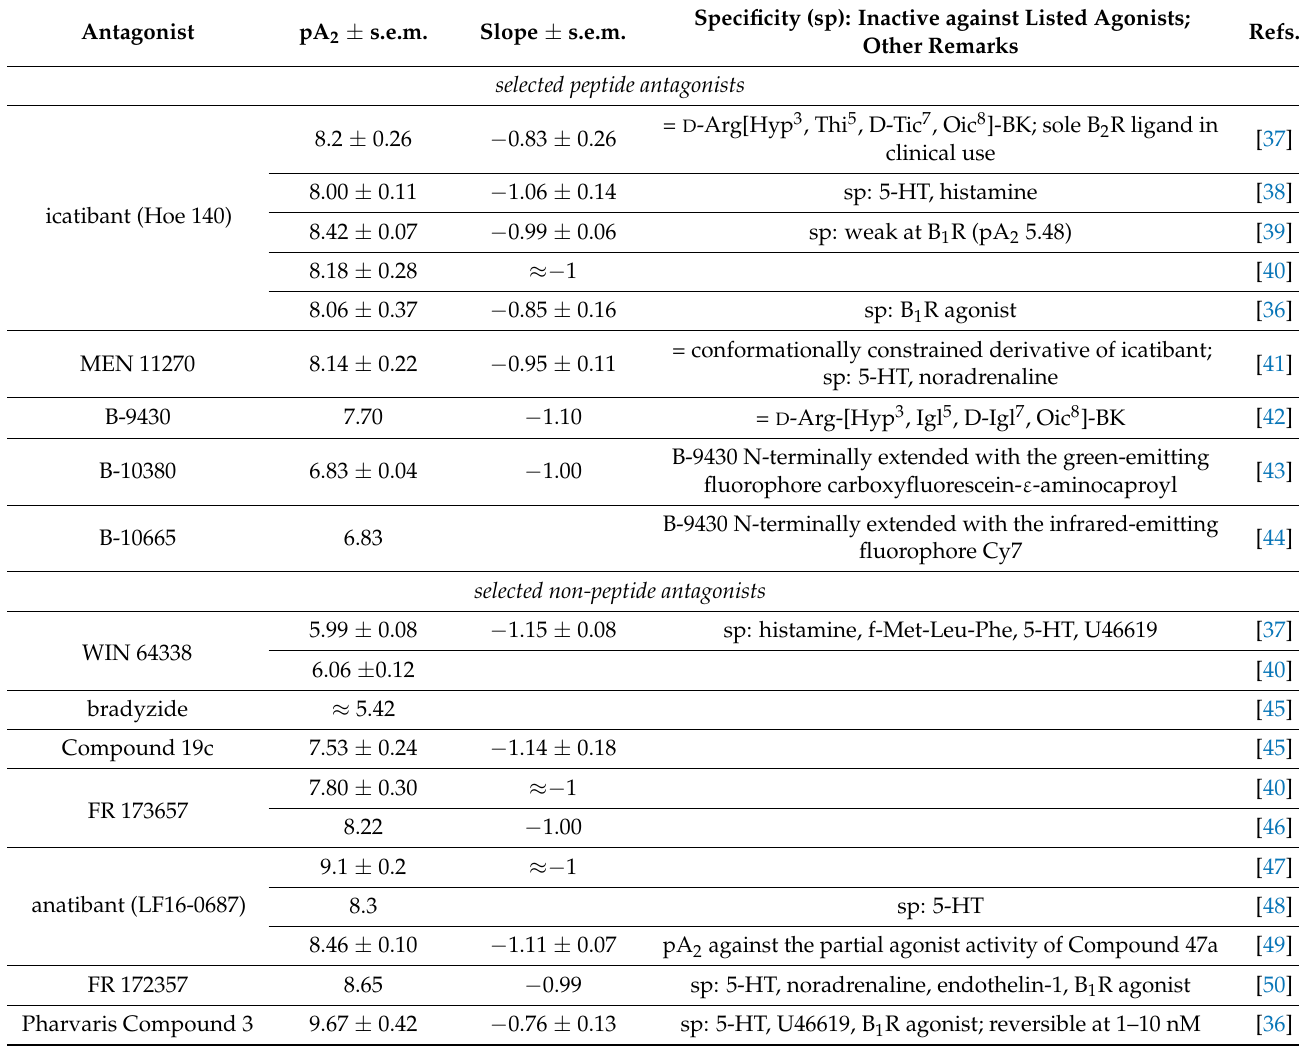
Table 1. Selected antagonist ligands of the bradykinin B2 receptor (B 2 R) evaluated using the human umbilical vein contractility